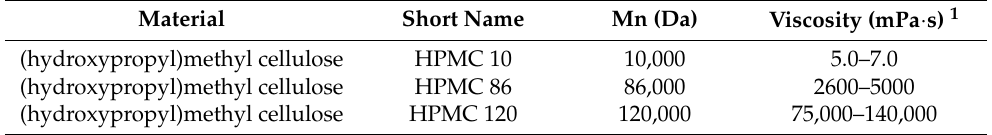
Table 2. Main characteristics of the (hydroxypropyl)methyl cellulose batches selected for this study. Material